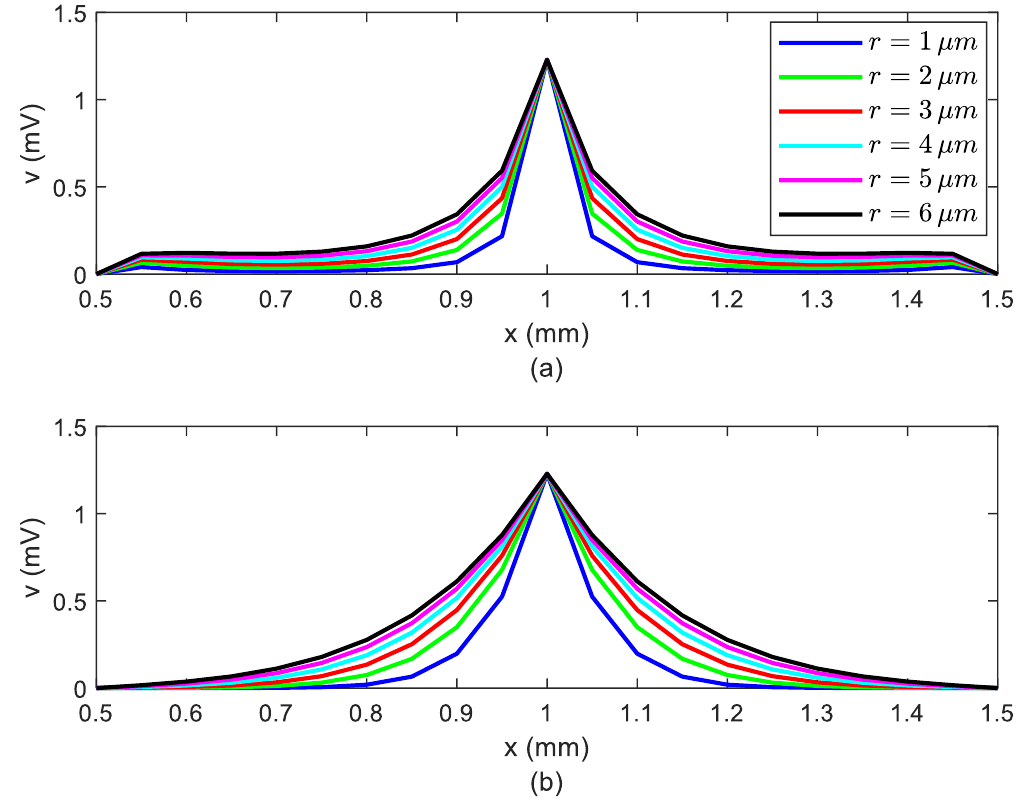
Figure 8. Profiles of 𝒗(𝒙, 𝒕) for (a) 𝜶 = 𝟎. 𝟔𝟓 and (b) 𝜶 = 𝟏 (bottom row) at 𝒕 = 𝟎. 𝟏 𝒎𝒔 and (b) 𝒙 = 𝟕𝟎𝟎 𝝁𝒎 for various values of the axon’s radius 𝒓